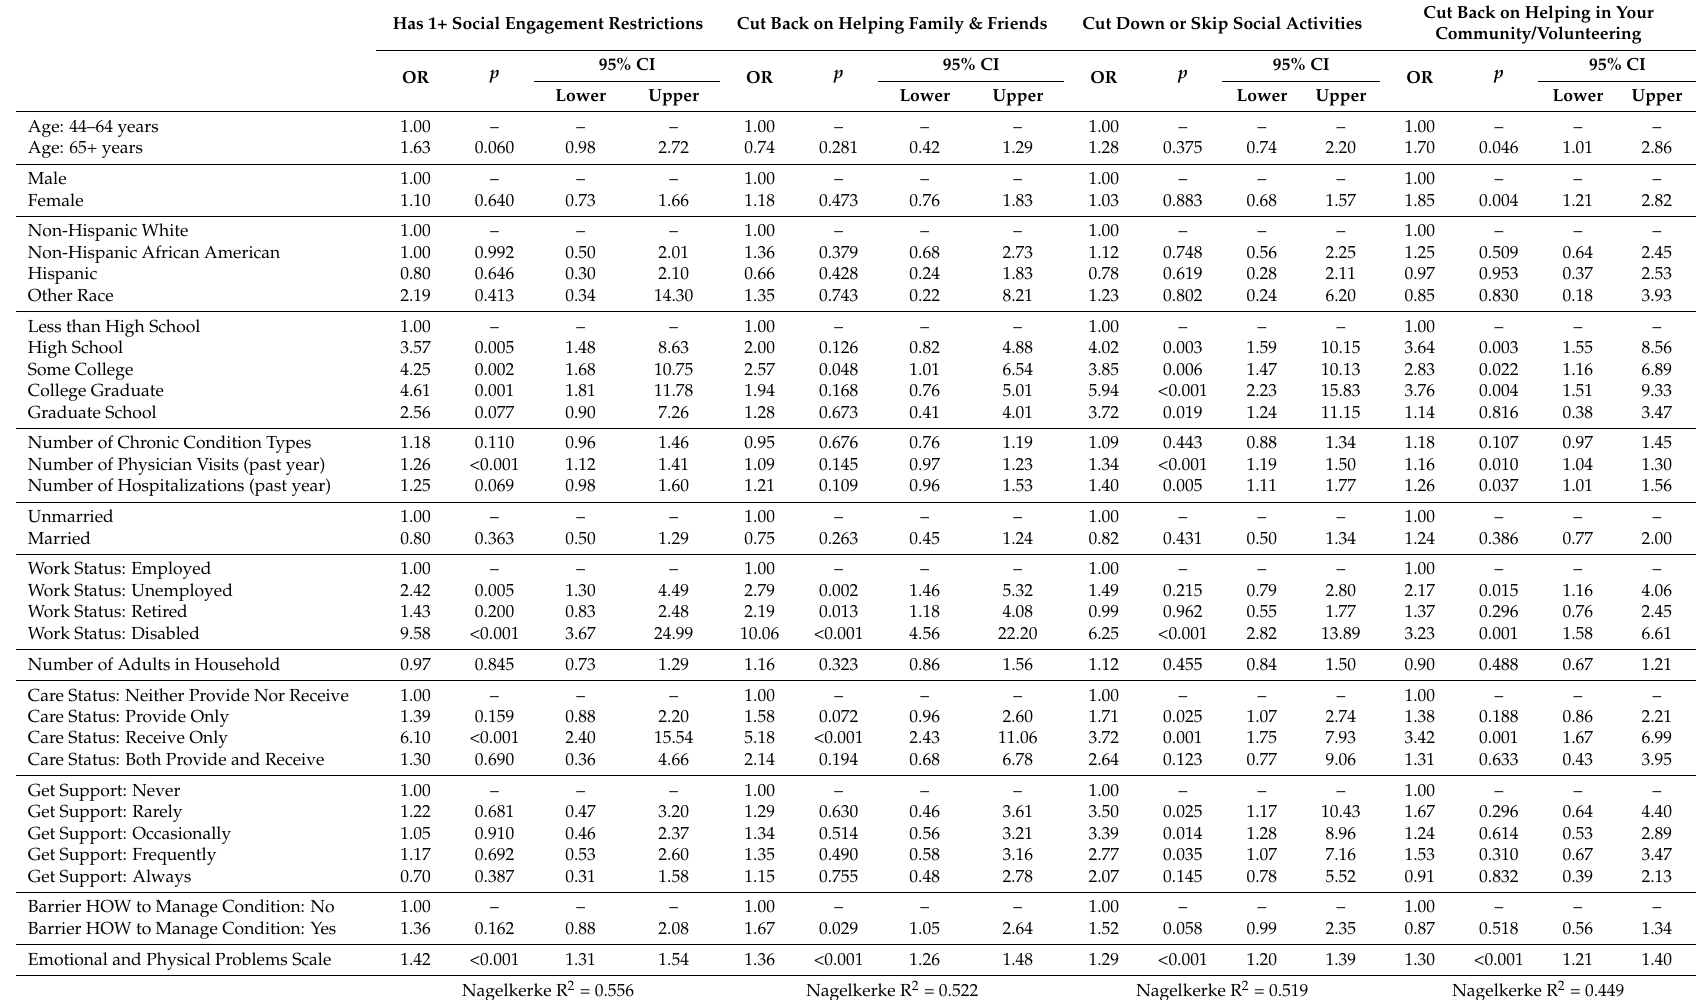
Table 2. Factors associated with social engagement restrictions resulting from health